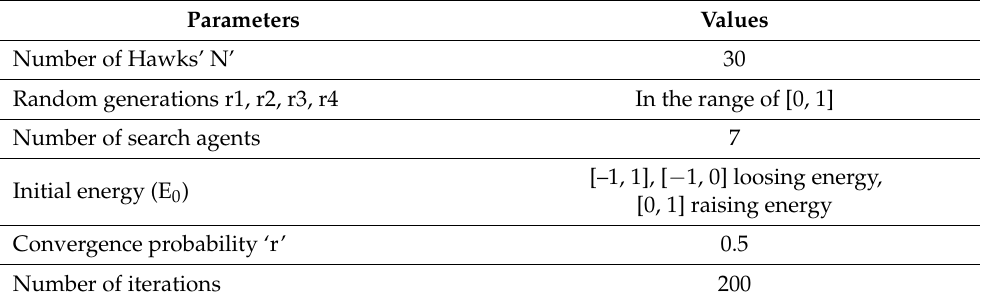
Table 4. Specifications and parameters of HHO.